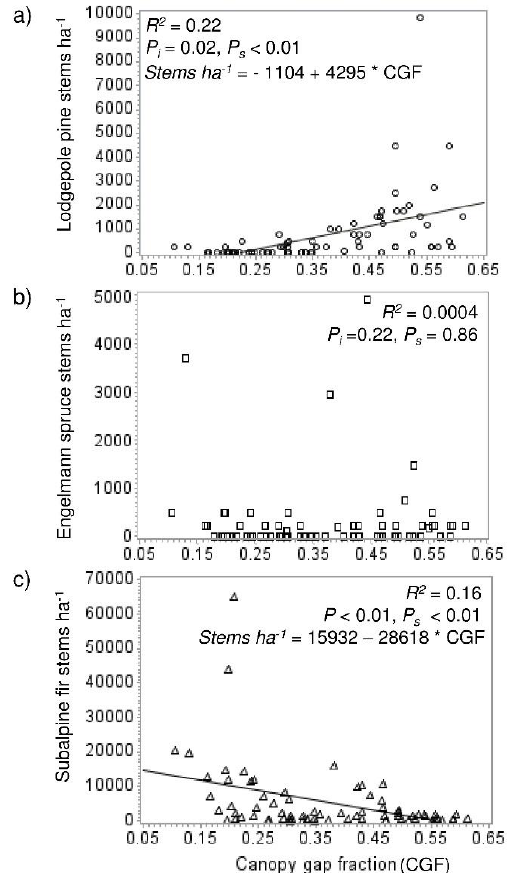
Figure 3. Linear relationships between lodgepole pine ( a ), Engelmann spruce ( b ), and subalpine fir recruitment density ( c ) (at the plot scale, n = 80) and canopy gap fraction. R 2 , p -values (for intercept [ P i ] and slope [ P s ]), and significant regression equations are shown. Forests 2018 , 9 , x FOR PEER REVIEW